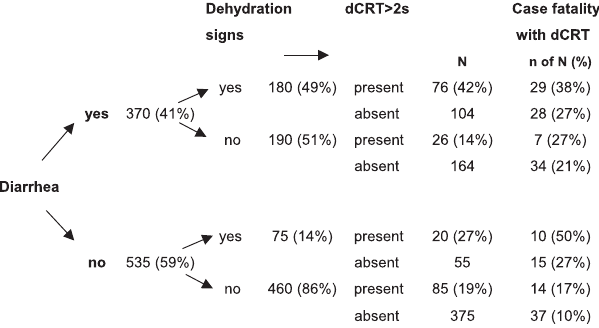
Figure 3. Value of the Signs of Dehydration and Delayed Capillary Refill Time (dCRT) in 905 Severely Malnourished Children with and without